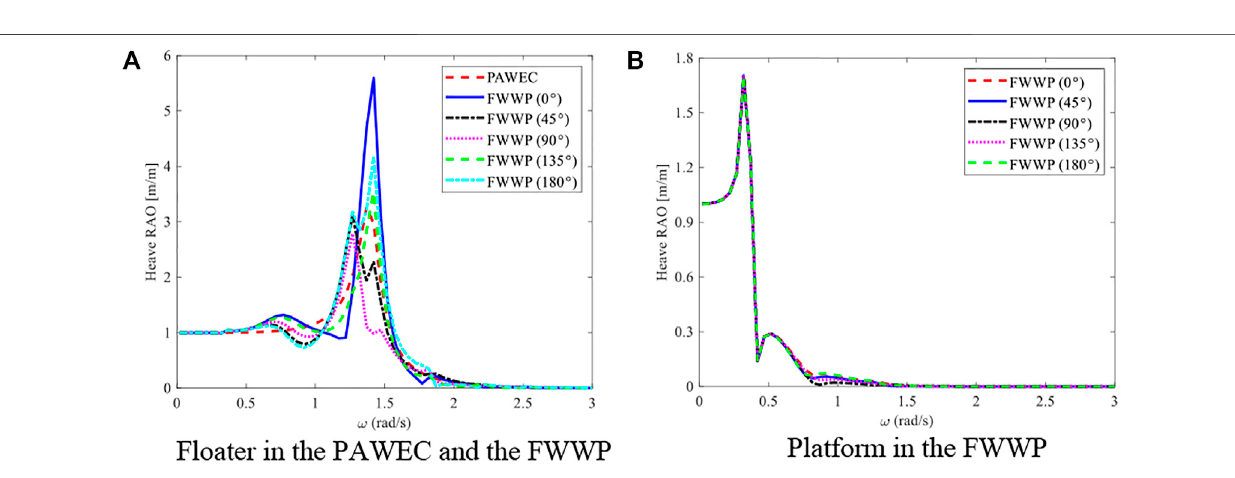
Frontiers in Energy Research |